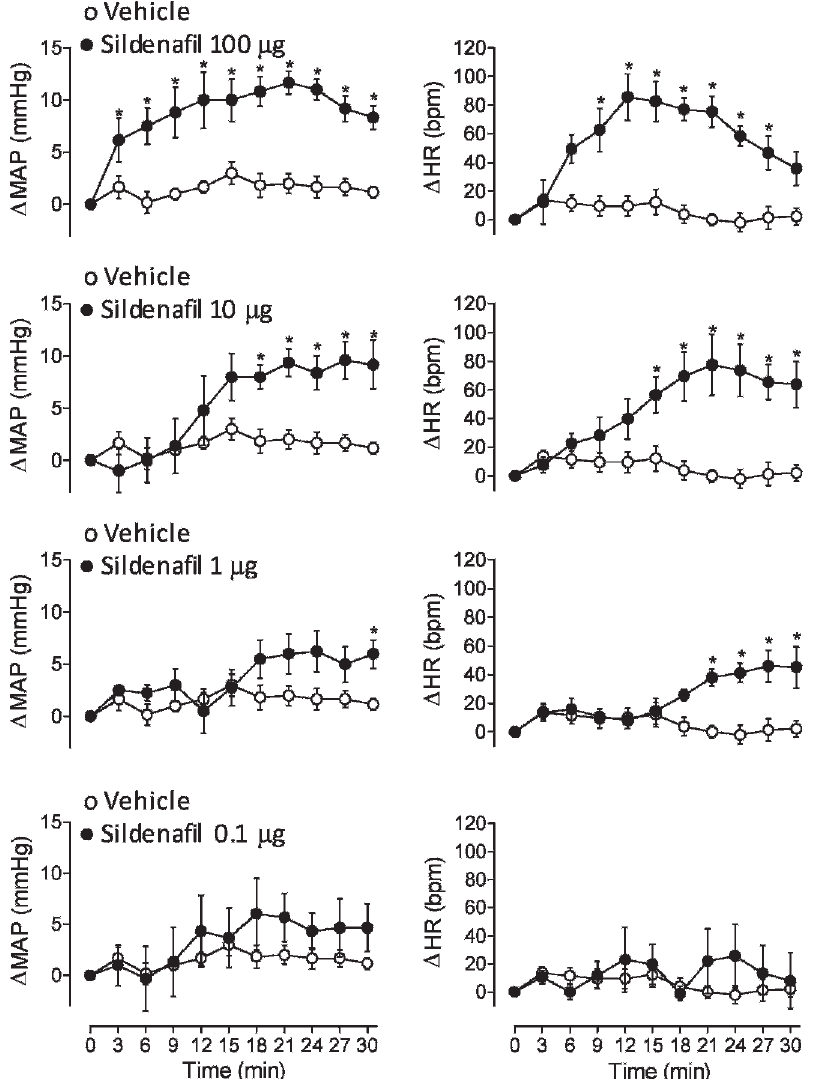
Figure 1 - Time course of the mean arterial pressure ( D MAP) and heart rate ( D HR) induced by the intrathecal administration of 100 m g (A), 10 m g (B), 1 m g (C), or 0.1 m g (D) sildenafil or the vehicle (DMSO). * p , 0.05 compared